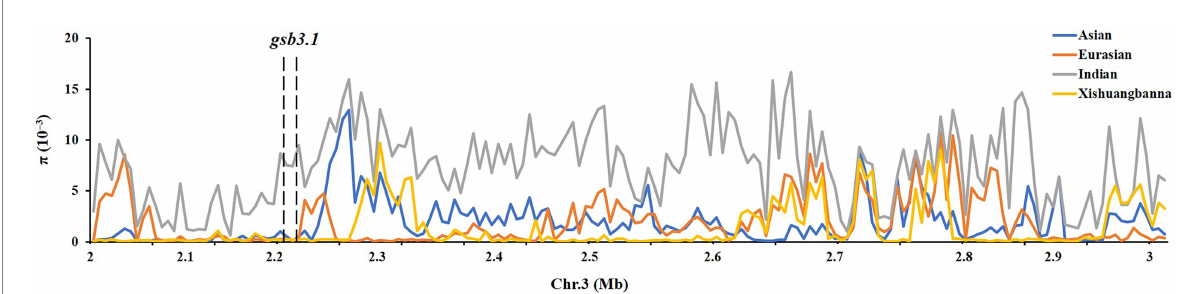
FIGURE 7 Distribution of nucleotide diversity ( π ) of four geographic groups. The region of gsb3.1 on Chr. Three overlaps with a large domestication sweep region showing reduced.